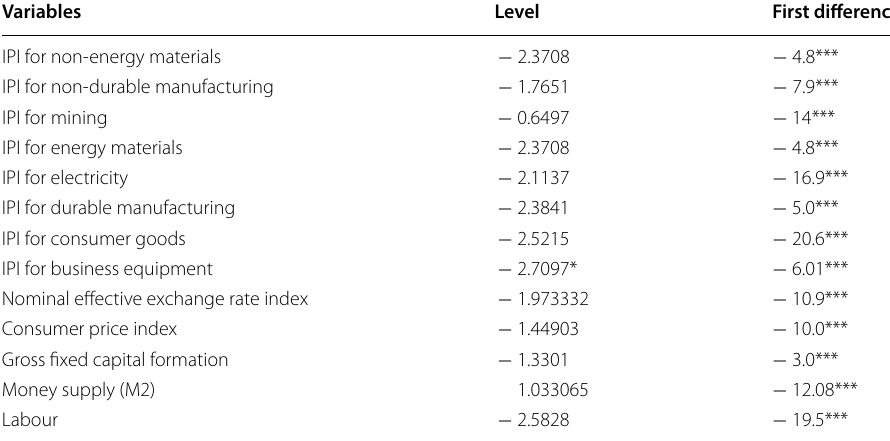
Table 1 Augmented Dickey Fuller test